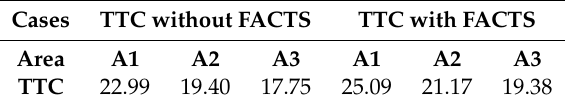
Table 5. TTC values of overall system for IEEE 30 bus